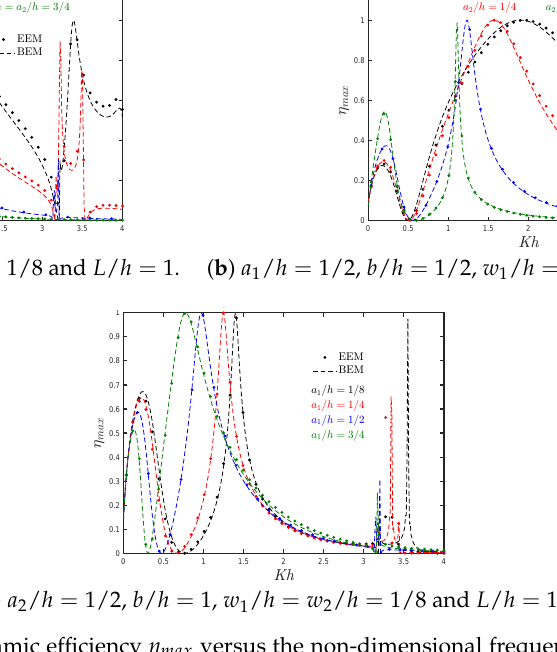
Figure 12. Maximum hydrodynamic efficiency η max versus the non-dimensional frequency Kh for different ( a ) submer- gence depths of the rear and front walls, a 1 / h and a 2 / h , respectively; ( b ) submergence depths of the front wall a 1 / h ; ( c ) submergence depths of the rear wall a 2 / h